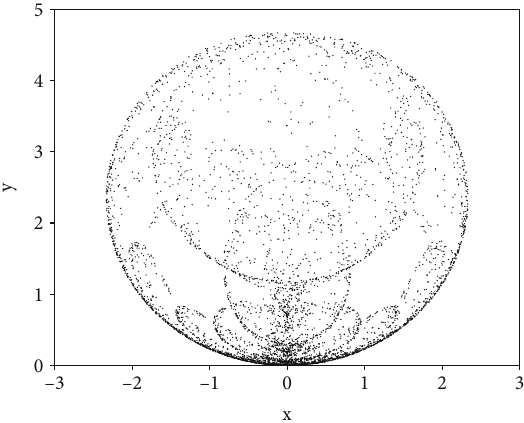
Figure 1: The chaotic attractor of map